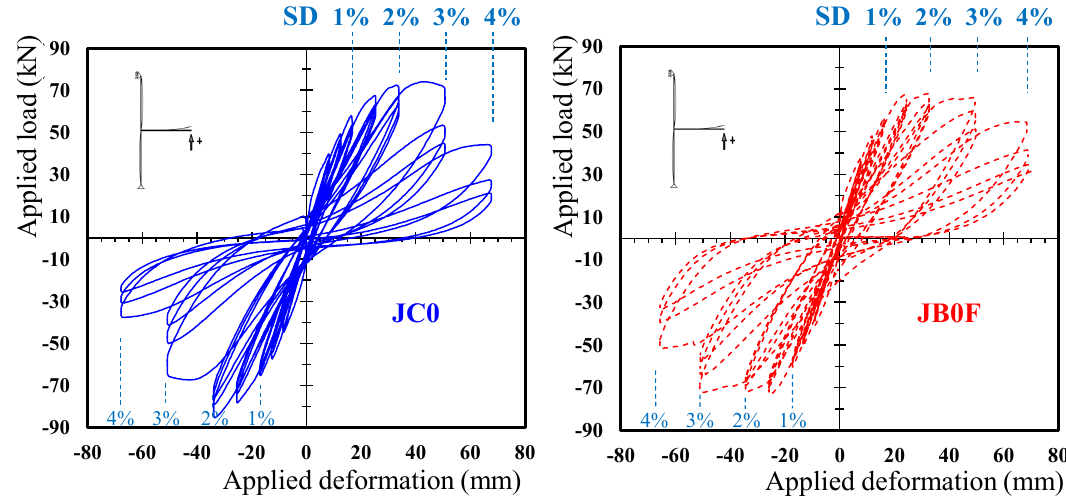
Figure 7. Hysteretic performance of subassemblages JC0 and JB0F.